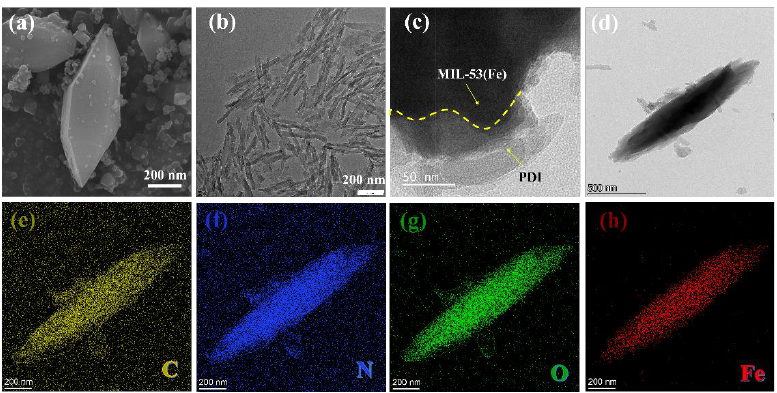
Figure 3. SEM image of ( a ) MIL-53(Fe), ( b ) TEM of PDI, and ( c , d ) M53@PDI-20, ( e – h ) elemental mapping image of M53@PDI-20 heterojunctions.